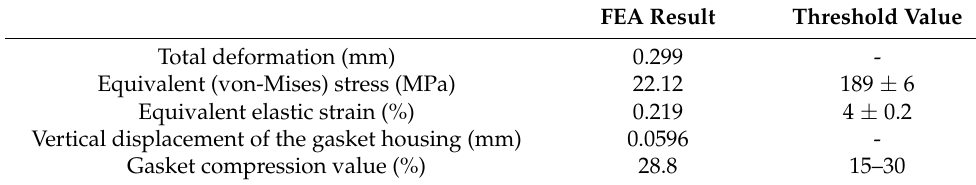
Table 4. FEA results for the camshaft cover vs. threshold values.